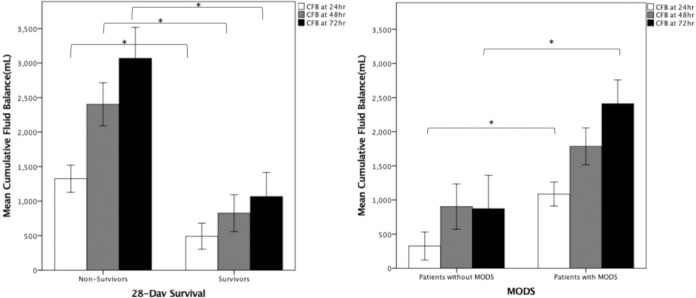
Relationship between cumulative fluid balance, MODS, and 28-day survival.(A) Cumulative fluid balances were significantly higher in non-survivors than in survivors of septic shock on 24 hr (open bar), 48 hr (gray bar), and 72 hr (black bar) (* indicates p<0.05); (B) Cumulative fluid balances were higher in patients with multi-organ dysfunction syndrome (MODS) than patients without MODS only on 24 hr (open bar) and 72 hr (black bar) (p = 0.035) but not on 48 hr (gray bar) of septic shock (* indicates p<0.05) (data expressed as mean ± SEM).